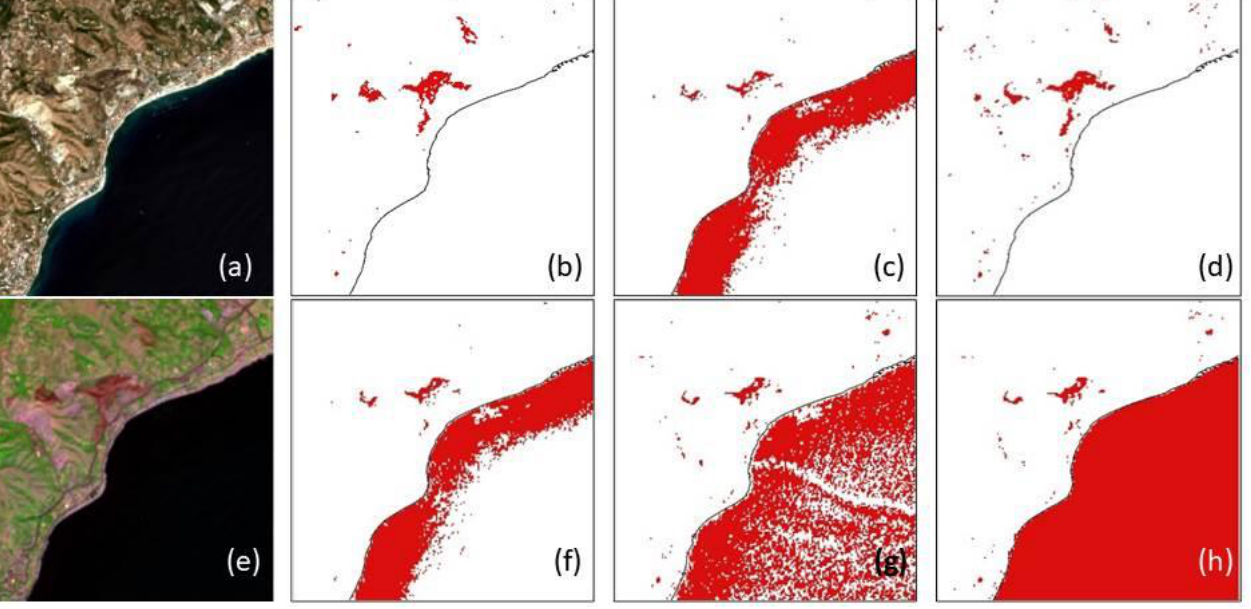
Figure 10. The impact of water bodies on BA/NON BA detections supplied by each index: RGB true color composition ( a ), NBR+ ( b ), NDSWIR ( c ), BAIS2 ( d ), false color composition ( e ), NBR ( f ), NBRSWIR ( g ), MIRBI ( h ).